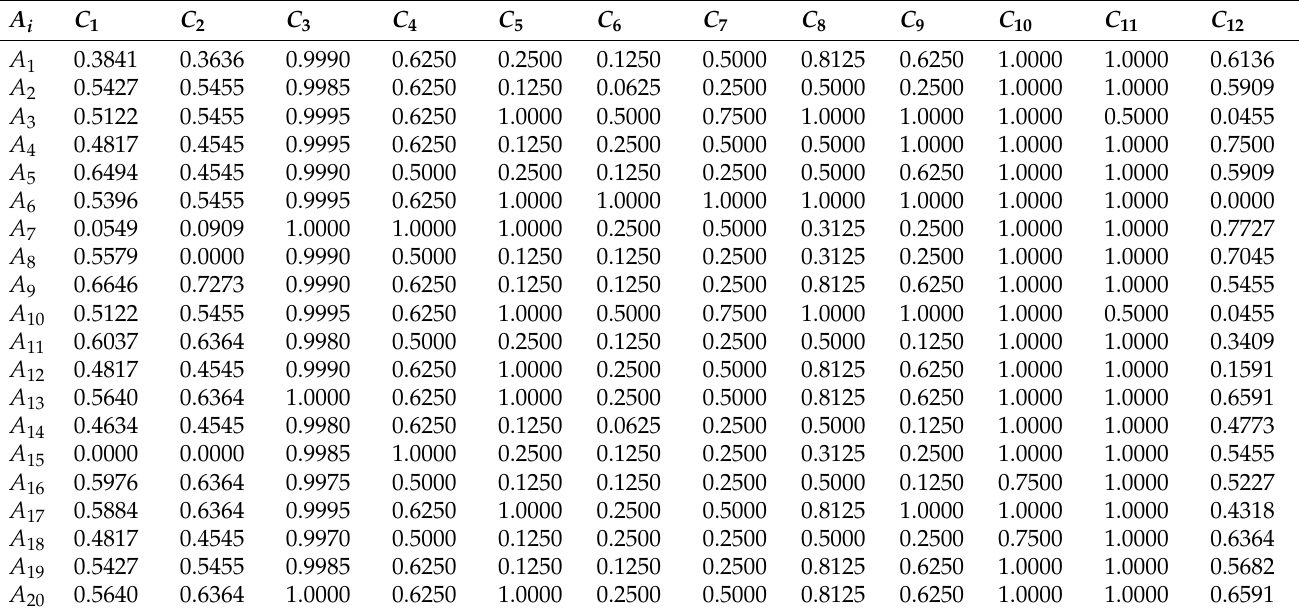
Table 5. Normalized decision matrix for a small set of alternatives.